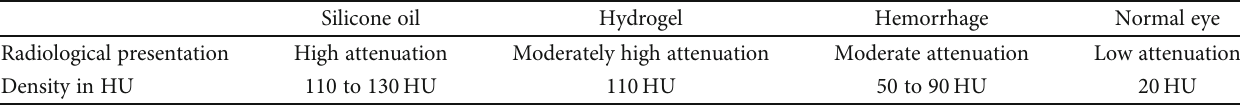
Table 1: Di ff erential diagnoses on CT